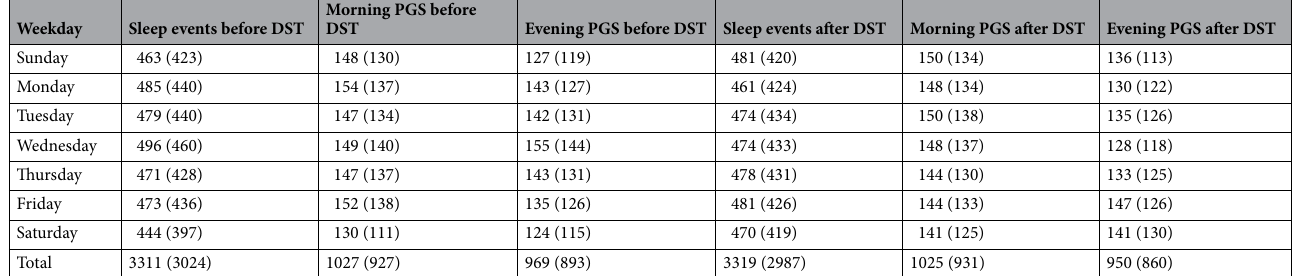
Table 1. Number of weekday sleep events before and after DST. Here, we list the total number of nighttime sleep events the weeks before and after DST onset starting on the respective day of the week (columns 2 and 5). Furthermore, we list the number of sleep events of the morning population (before DST, column 3 and after DST, column 6) and the evening population (columns 4 and 7). The values listed in parentheses are the number of sleep events that are greater than four